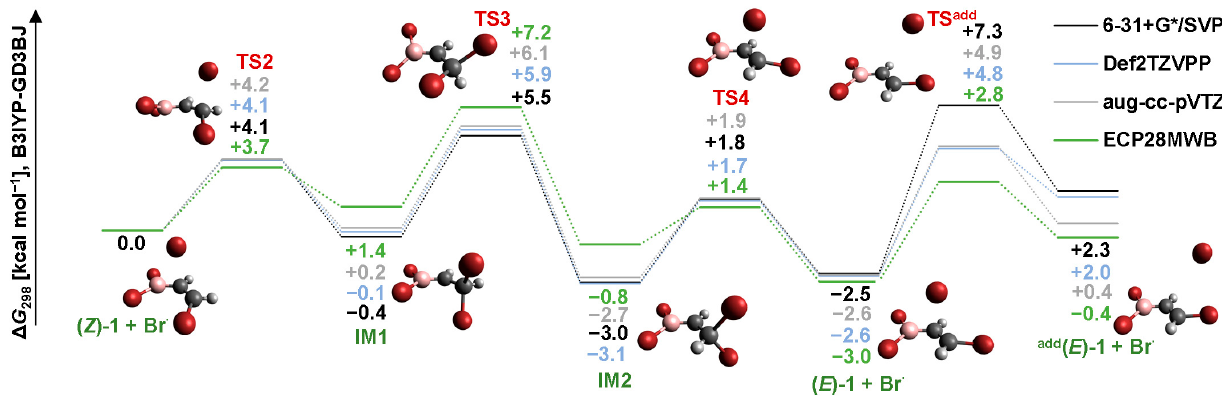
Figure 3. B3LYP-GD3BJ (ECP28MWB only for bromine atoms) Gibbs free energy profile for bromine radical addition to the “bromine end” of ( Z )-1 . For a key to atom color scheme, cf. caption of Figure 1.